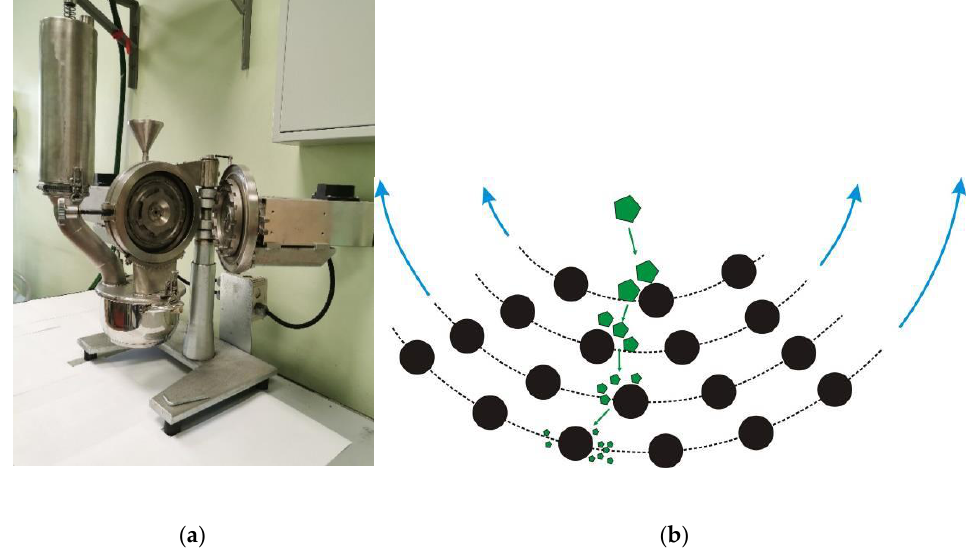
Figure 12. An example of the real-world disintegrator ( a ) and a schematic showing the motion of particles in the disintegrator ( b ).